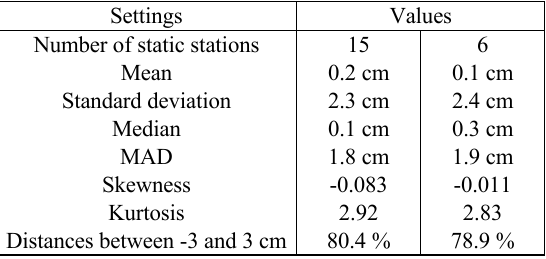
Table 3. Results of registration with 15 and 6 static stations